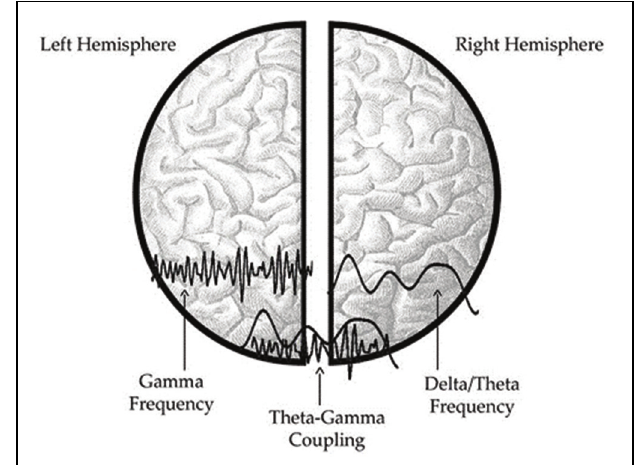
FIGURE 3 | Illustration of the Brain Asymmetry Hypothesis (made by the author).